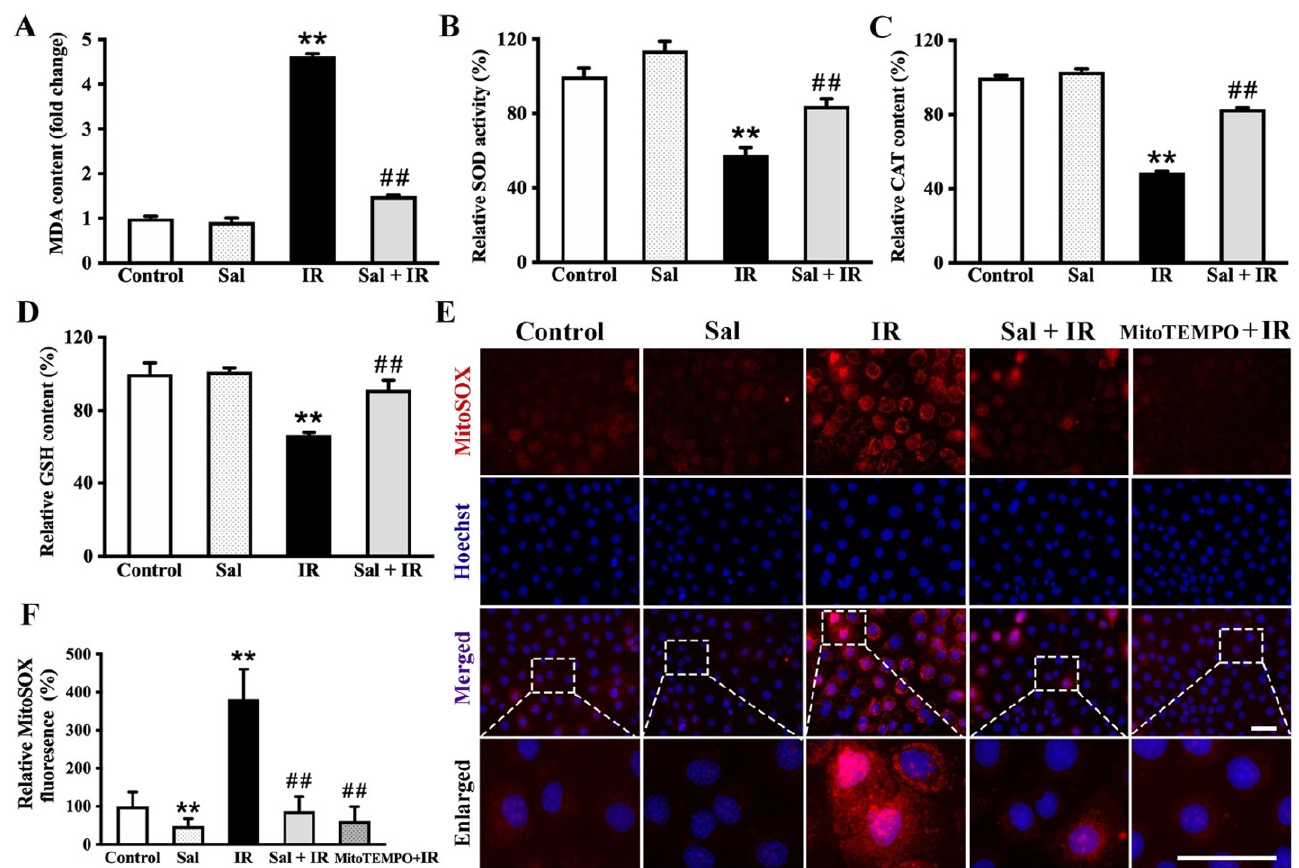
Figure 2. Salidroside enhanced antioxidant defense and reduced mitochondrial ROS in irradiated SMG cells. SMG-C6 cells were pretreated with 10 μM salidroside for 24 h before exposure to 15 Gy X-ray and detected after irradiation for 48 h. ( A ) MDA level, ( B ) relative SOD activity, ( C ) relative CAT content, and ( D ) relative GSH content were determined using the relevant kits. ( E ) Levels of mitochondrial ROS were detected by MitoSOX™ red (bar = 50 μm). Red fluorescence indicates positive staining. ( F ) Quantitative analysis of the mitochondrial ROS in ( E ). The data are presented as the mean ± SEM from 3 independent experiments, with each sample analyzed in triplicate. ** p < 0.01 vs. the controls; ## p < 0.01 vs. the irradiation